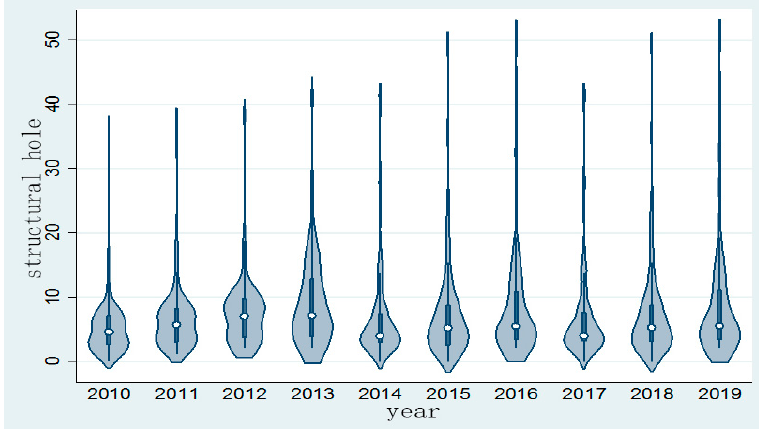
Figure 6. Violin diagram of knowledge-based network structural hole .